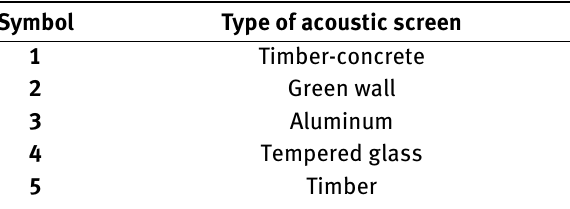
Figure 7: Graph 2W of coordinates of technological and material projects. Table 5: Symbols of acoustic screens on the biplot